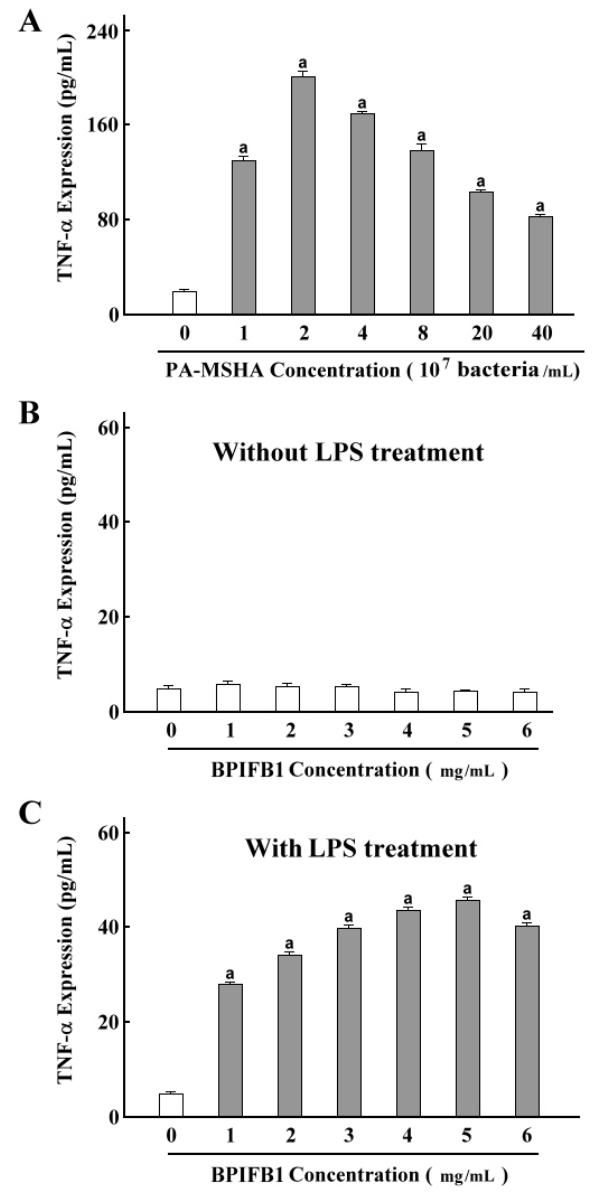
Figure 1: PA-MSHA and BPIFB1 dose dependent assay. A. The human monocytic leukemia cell line THP-1 was treated with 100 ng/ml PMA for 48 hours. Differentiated THP-1 cells were incubated with medium containing PA-MSHA (0, 1 × 10 7 , 2 × 10 7 , 4 × 10 7 , 8 × 10 7 , 20 × 10 7 , and 40 × 10 7 bacteria/ml) for 24 hours. B and C. Purified BPIFB1 protein (0, 1, 2, 3, 4, 5, and 6 mg/ml) was added into the differentiated THP- 1cells with or without 10 ng/ml of LPS for 24 hours. Culture superna- tants were used to assess PA-MSHA or BPIFB1 dose-response effects using the Quantikine TNF-α ELISA Assay kit. The results shown represent the mean±SEM of at least three independent